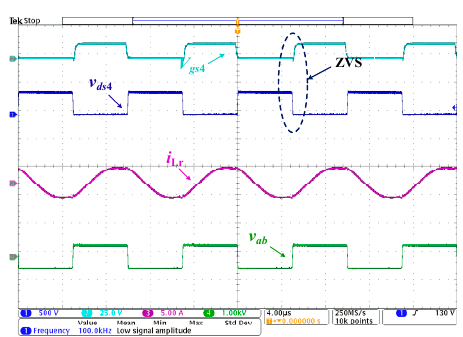
Figure 8. D Vgs5 = 1, R L = 50 ohm, Vo = 400 V, f s = 100 kHz.